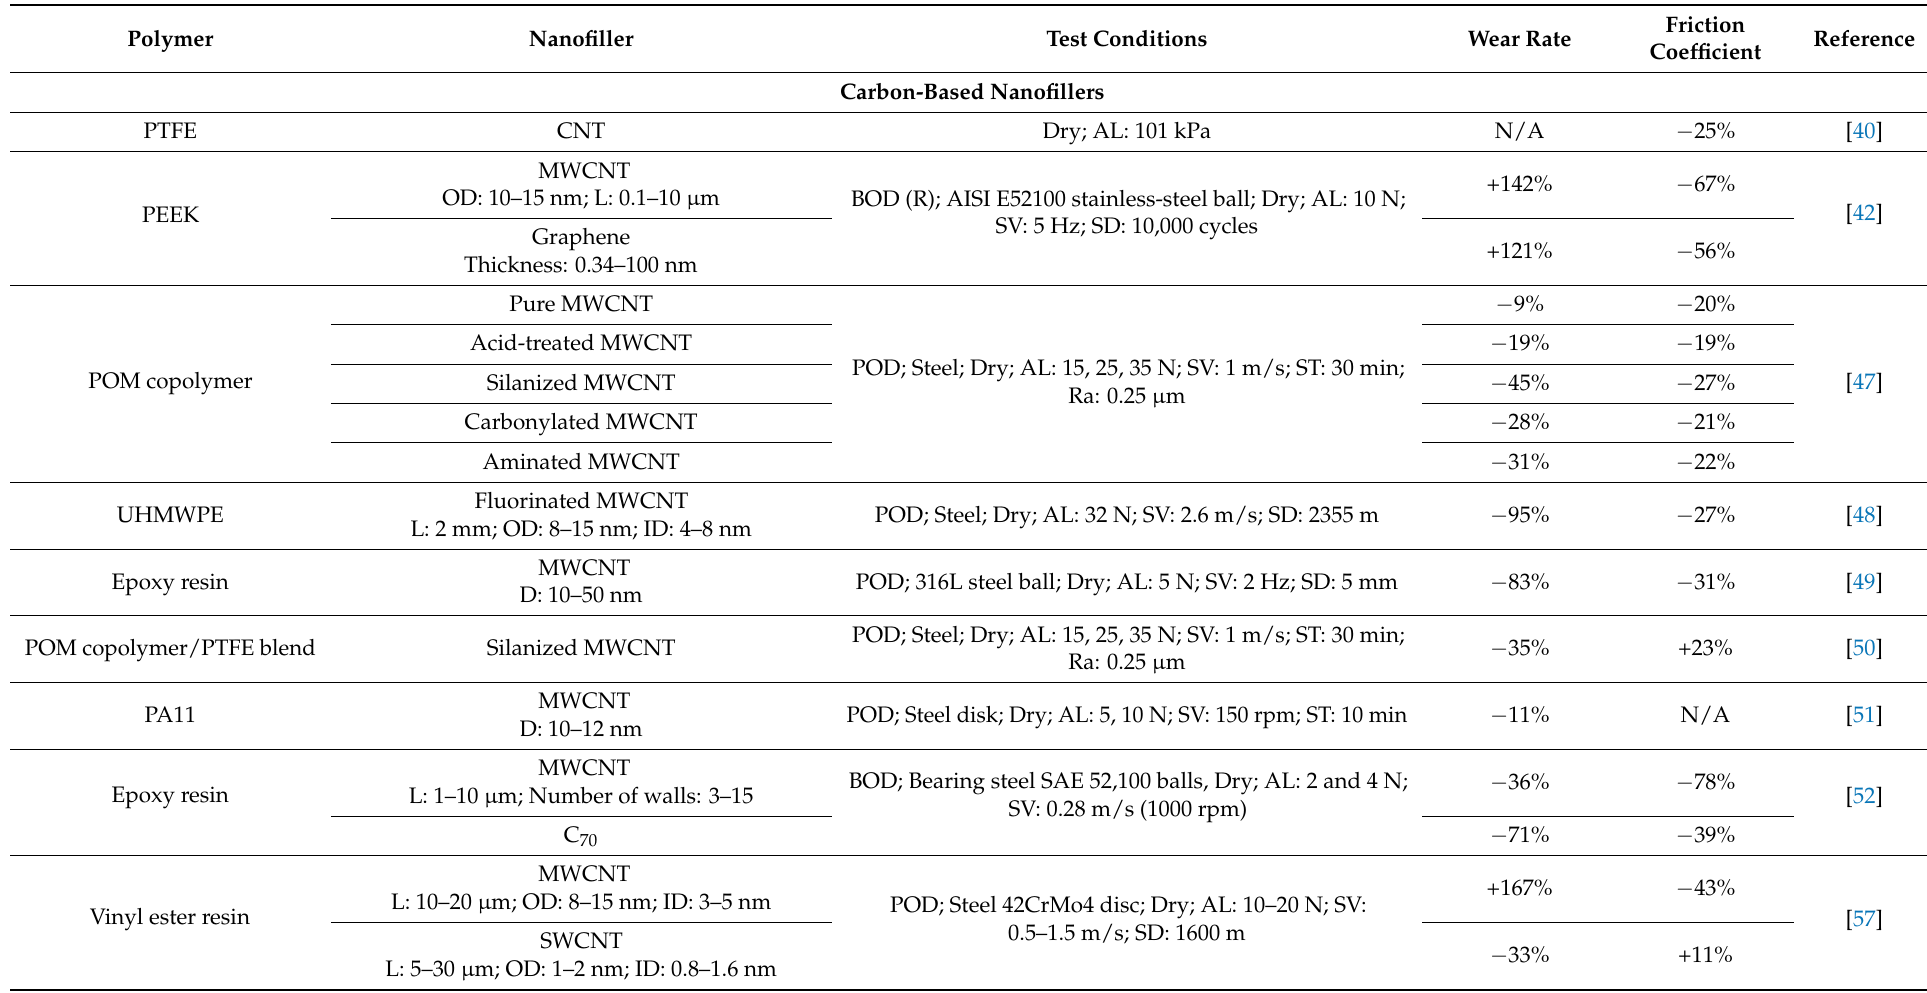
Table 1. Tribological properties of polymer nanocomposites based on types of